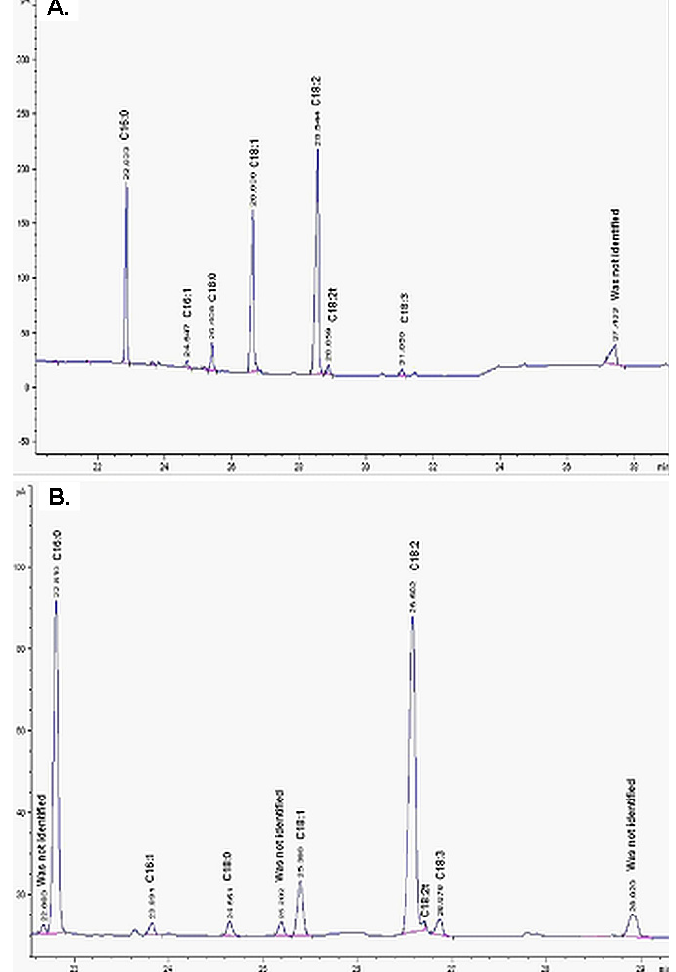
Figure 3. Variation of fatty acids methyl esters content of amaranth oil extracted with hexane without (A) and with (B) application of heat, determined by gas chromatography.